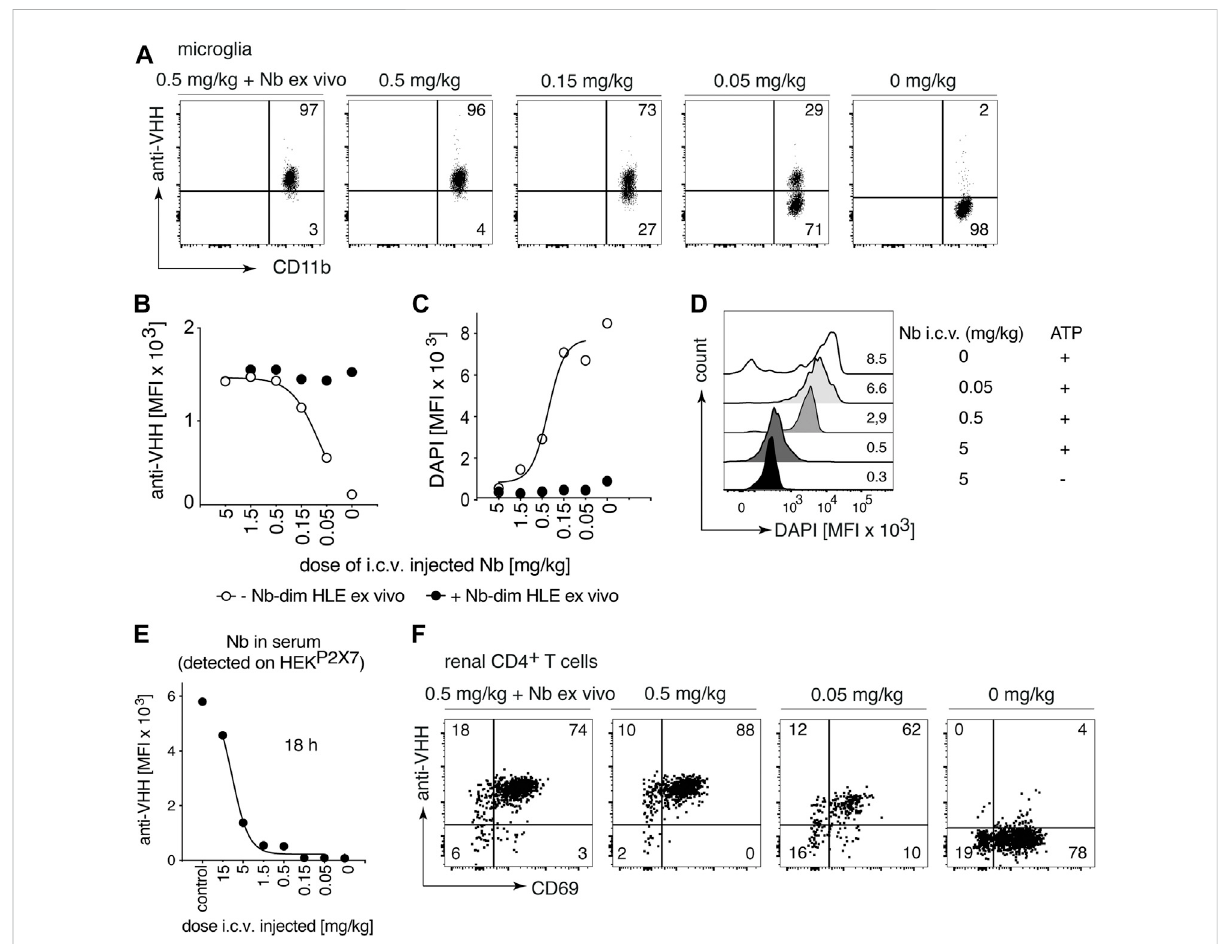
Full occupancy of P2X7 on microglia is achieved after an i.c.v. injection of a low dose of P2X7 nanobody. Titrated amounts of bivalent HLE nanobody 1c81 s -dim HLE wereinjected i.c.v. and 18 hlater theoccupancy of P2X7bythenanobodywas analyzed onmicroglia